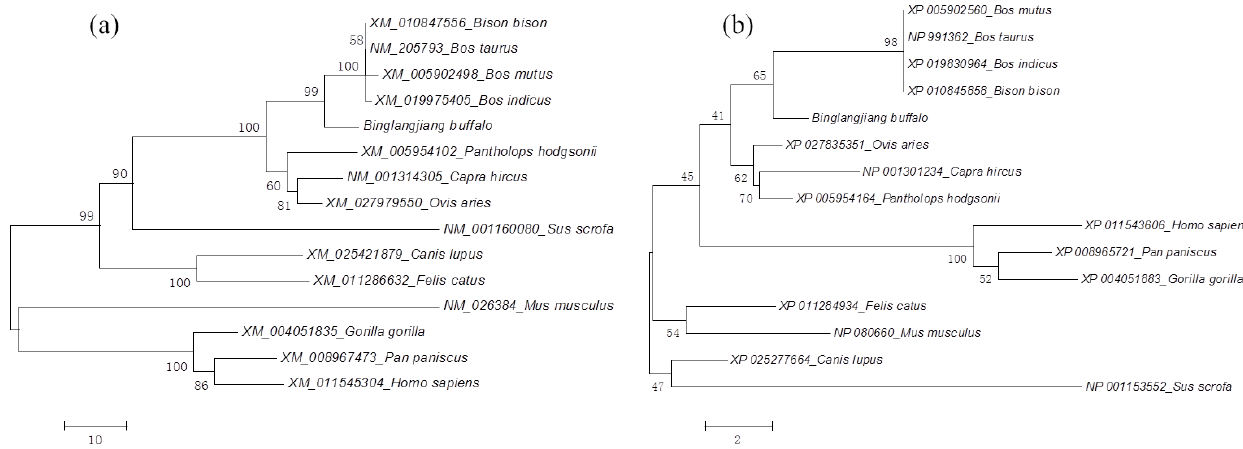
Figure 3. Phylogenetic tree based on DGAT2 sequences. (a) Phylogenetic tree based on nucleotide sequences and (b) phylogenetic tree based on amino acid